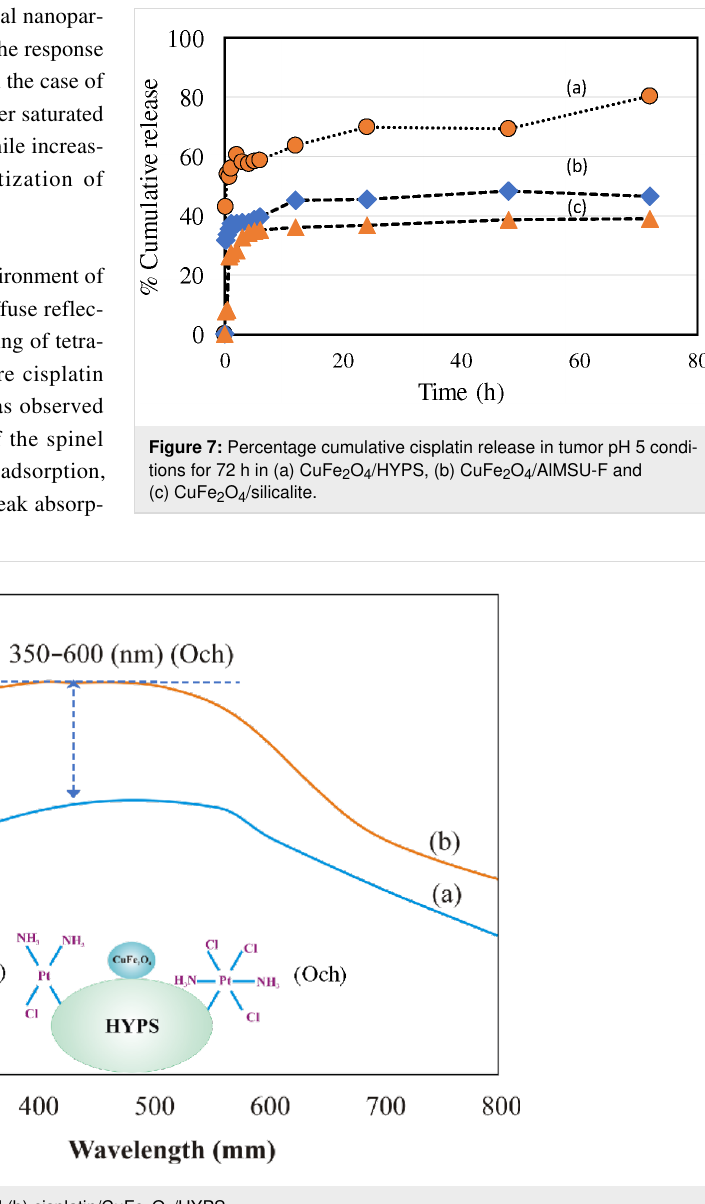
site of Cu, in order to induce variable magnetization properties.